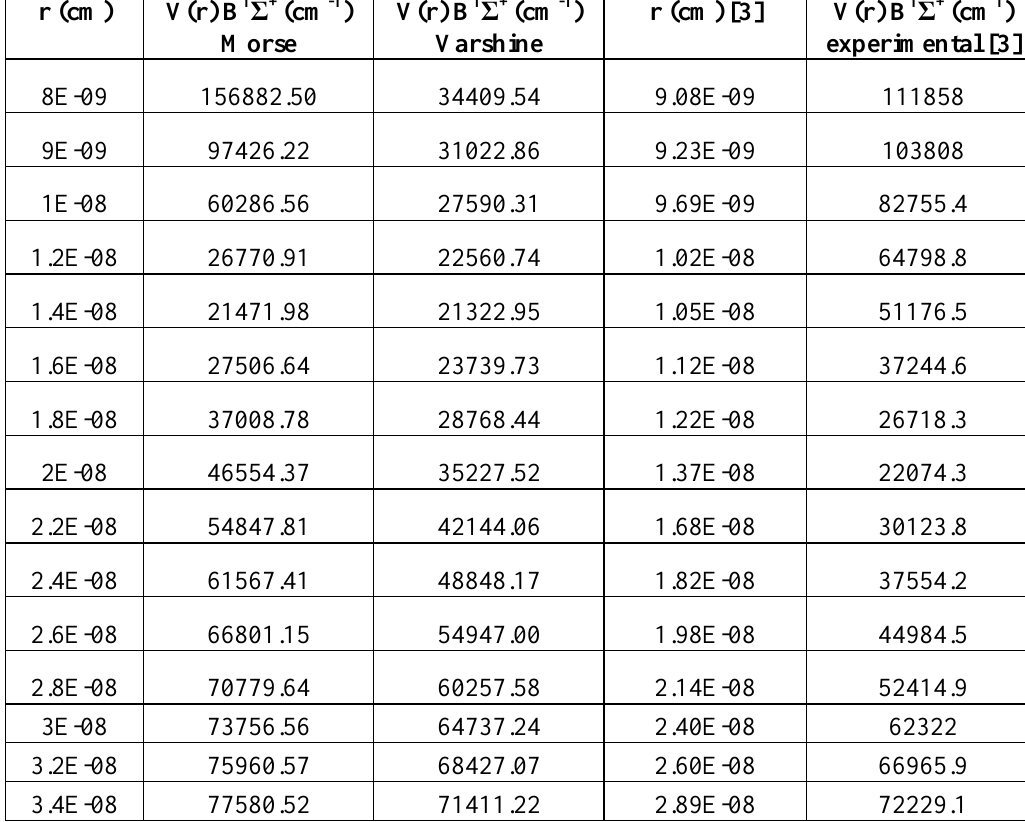
Table 4: Theoretical and experimental values of potential energy for exited states B 1 Σ + of BeO